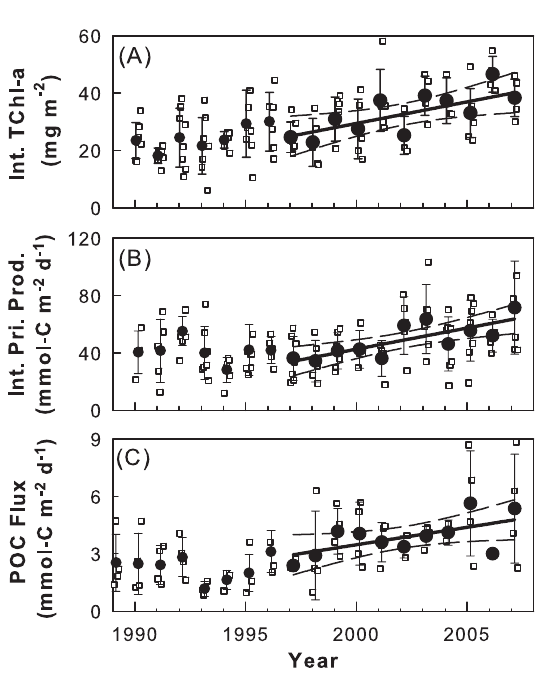
Fig. 1. Time-series, data from January to April each year, of bio- logical carbon pump components in the Sargasso Sea. (a) Integrated (0–140m) HPLC TChl- a , (b) integrated (0–14 m) in situ primary production and (c) sediment trap POC flux at 150m. In all panels, open squares are data for January through April of each year. The filled symbols are the mean ( ± std. dev.) of the data for each win- ter/spring period. The solid lines in each panel are the least squares Model 1 linear regression and 95% confidence intervals (dashed line). All linear regressions are significant, P ≤ 0 . 05.